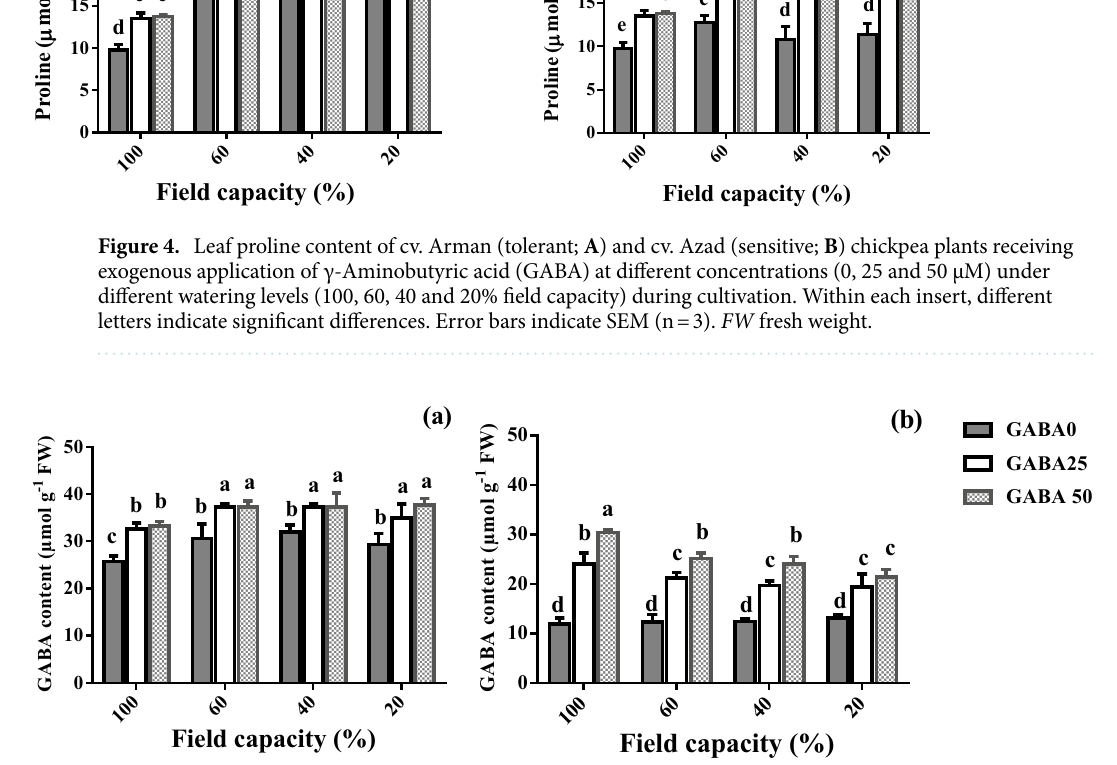
Figure 5. Leaf γ-aminobutyric acid (GABA) content of cv. Arman (tolerant; A ) and cv. Azad (sensitive; B ) chickpea plants receiving exogenous application of GABA at different concentrations (0, 25 and 50 μM) under different watering levels (100, 60, 40 and 20% field capacity) during cultivation. Within each insert, different letters indicate significant differences. Error bars indicate SEM (n = 3). FW fresh